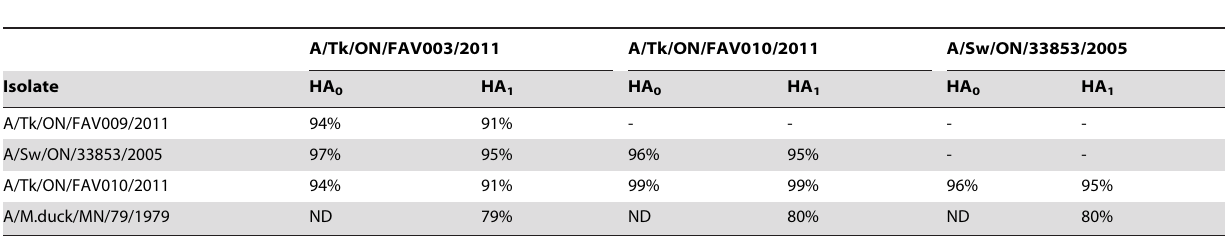
Table 6. Percent similarities in the amino acid residues of the HA0 and HA1 of the three H3N2 isolates from turkeys compared to a prototype cluster IV TR H3N2 strain.